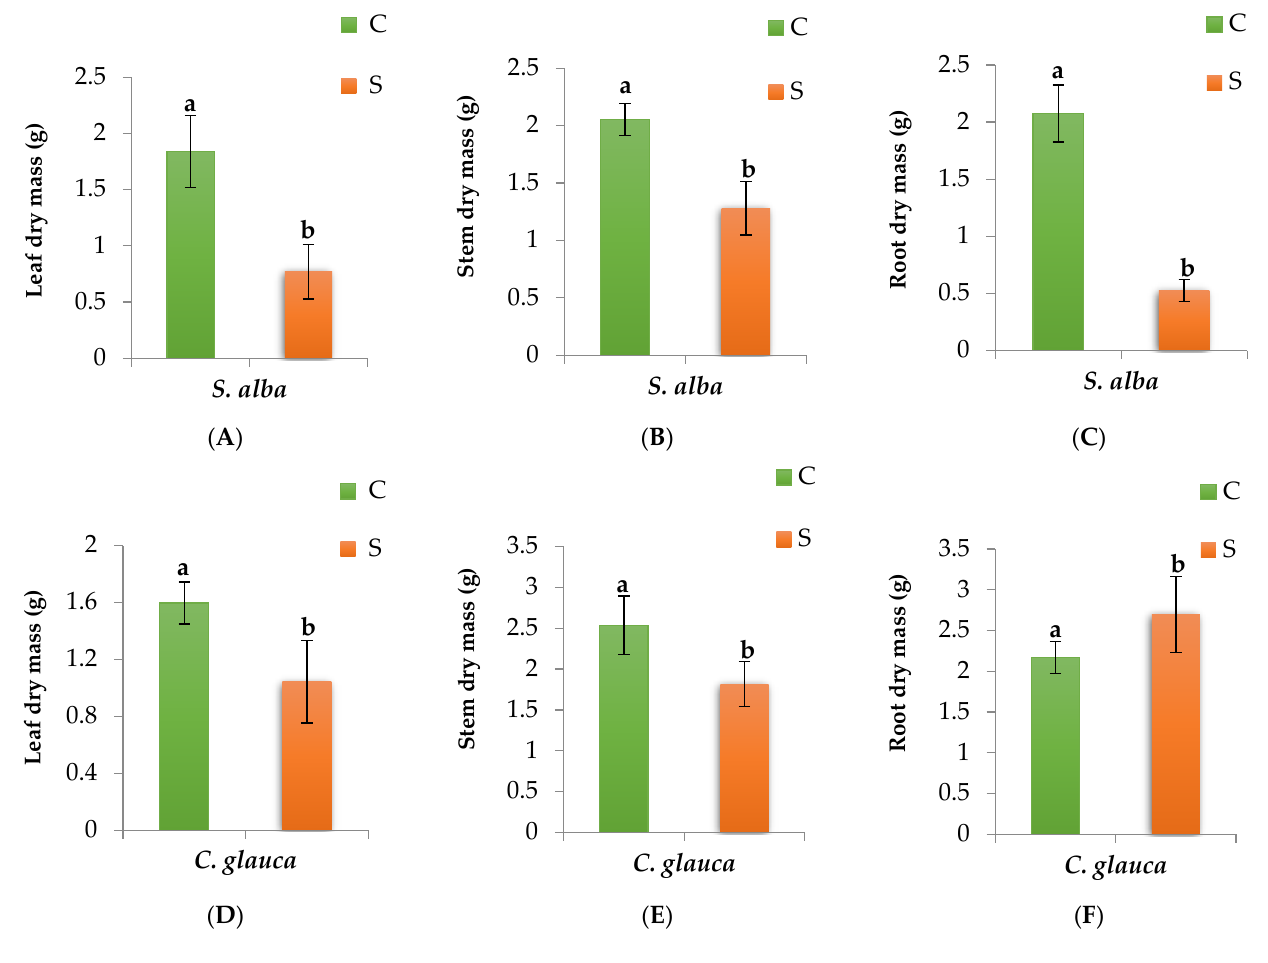
Figure 3. Comparison of leaf ( A , D ), stem ( B , E ) and root dry masses ( C , F ) in seedlings of S. alba and C. glauca treated with tap water (control, C) or with 25% industrial wastewater (25% IWW; stressed, S) after 35 days of treatment, (n = 5, mean ± SD). Different letters above the means indicate a significant difference at p < 0.05 according to Student–Newnan–Keuls (SNK) tests.